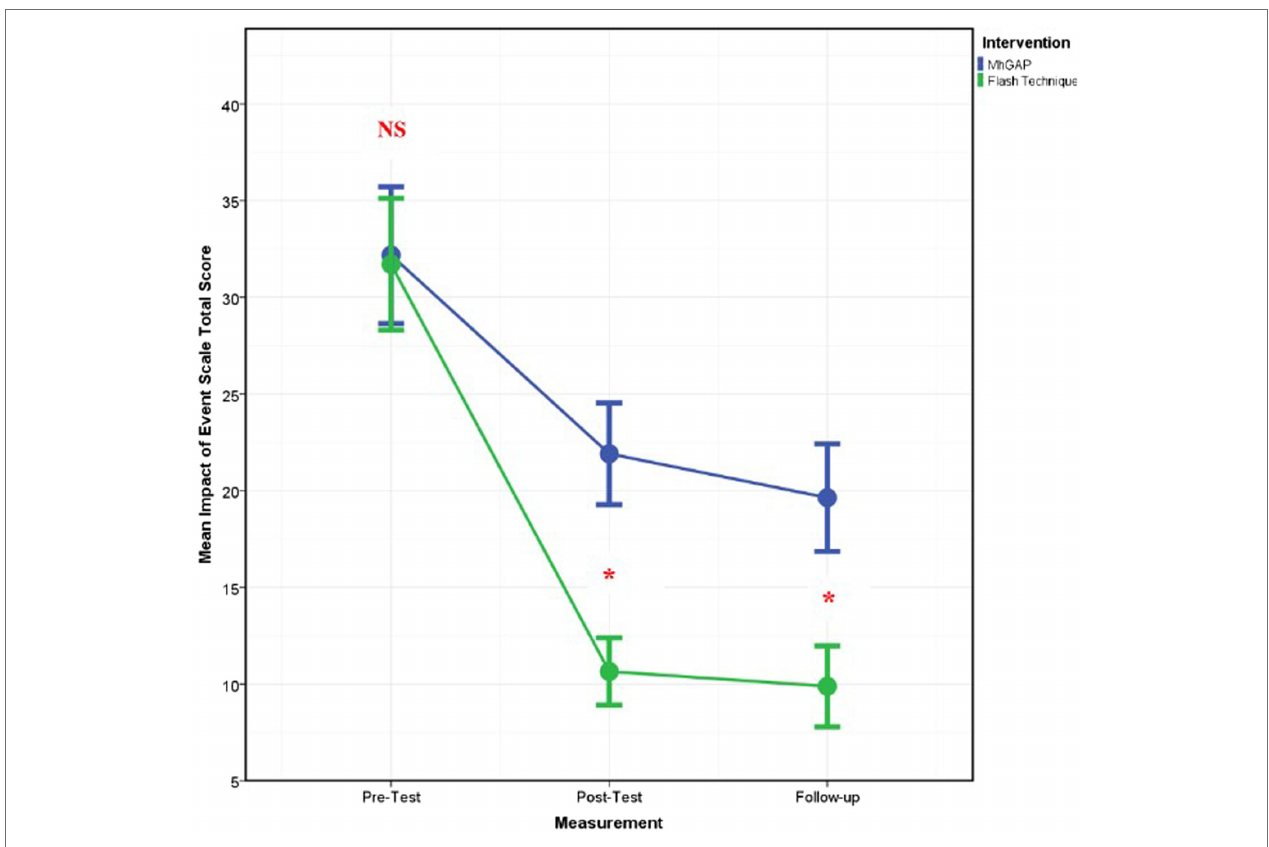
FIGURE 2 | Graph of change of IES-R total score between two applications. *: statistically